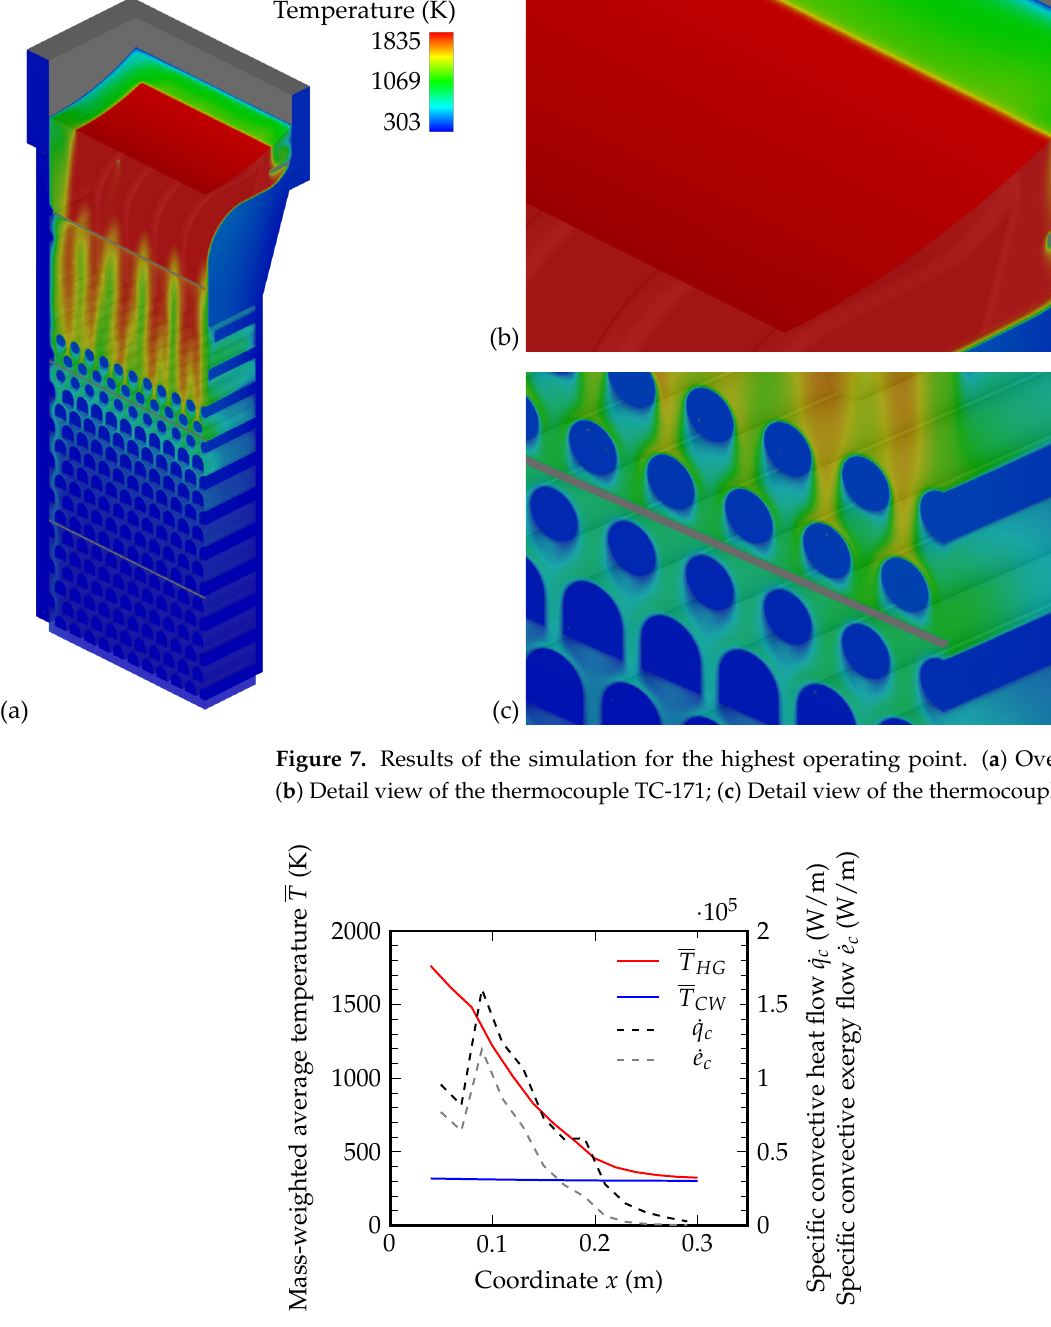
Figure 8. Spatial distribution of the mass-weighted average Temperature on the left axis and of the specific convective heat flow and according exergy flow on the right axis along the coordinate x for the highest operating